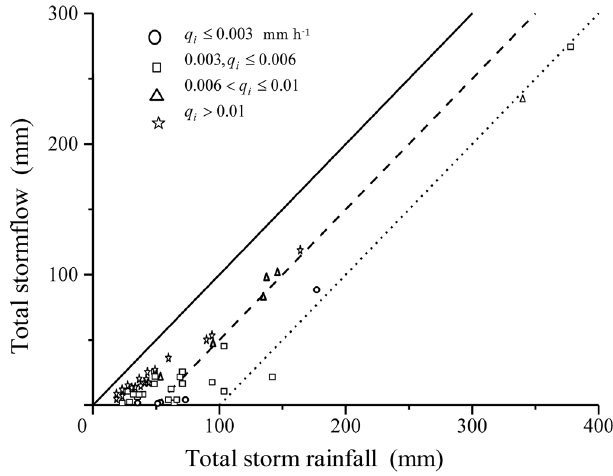
Fig. 1. Relationship of the total stormflow to the total storm rainfall in KT in TEF. q i : runoff rate before the storm event. Solid, bro- ken, and dotted lines indicate Q = R, Q = R − 50 , Q = R − 100, respectively, where R is the total storm rainfall and Q is the total stormflow. After Tani and Abe